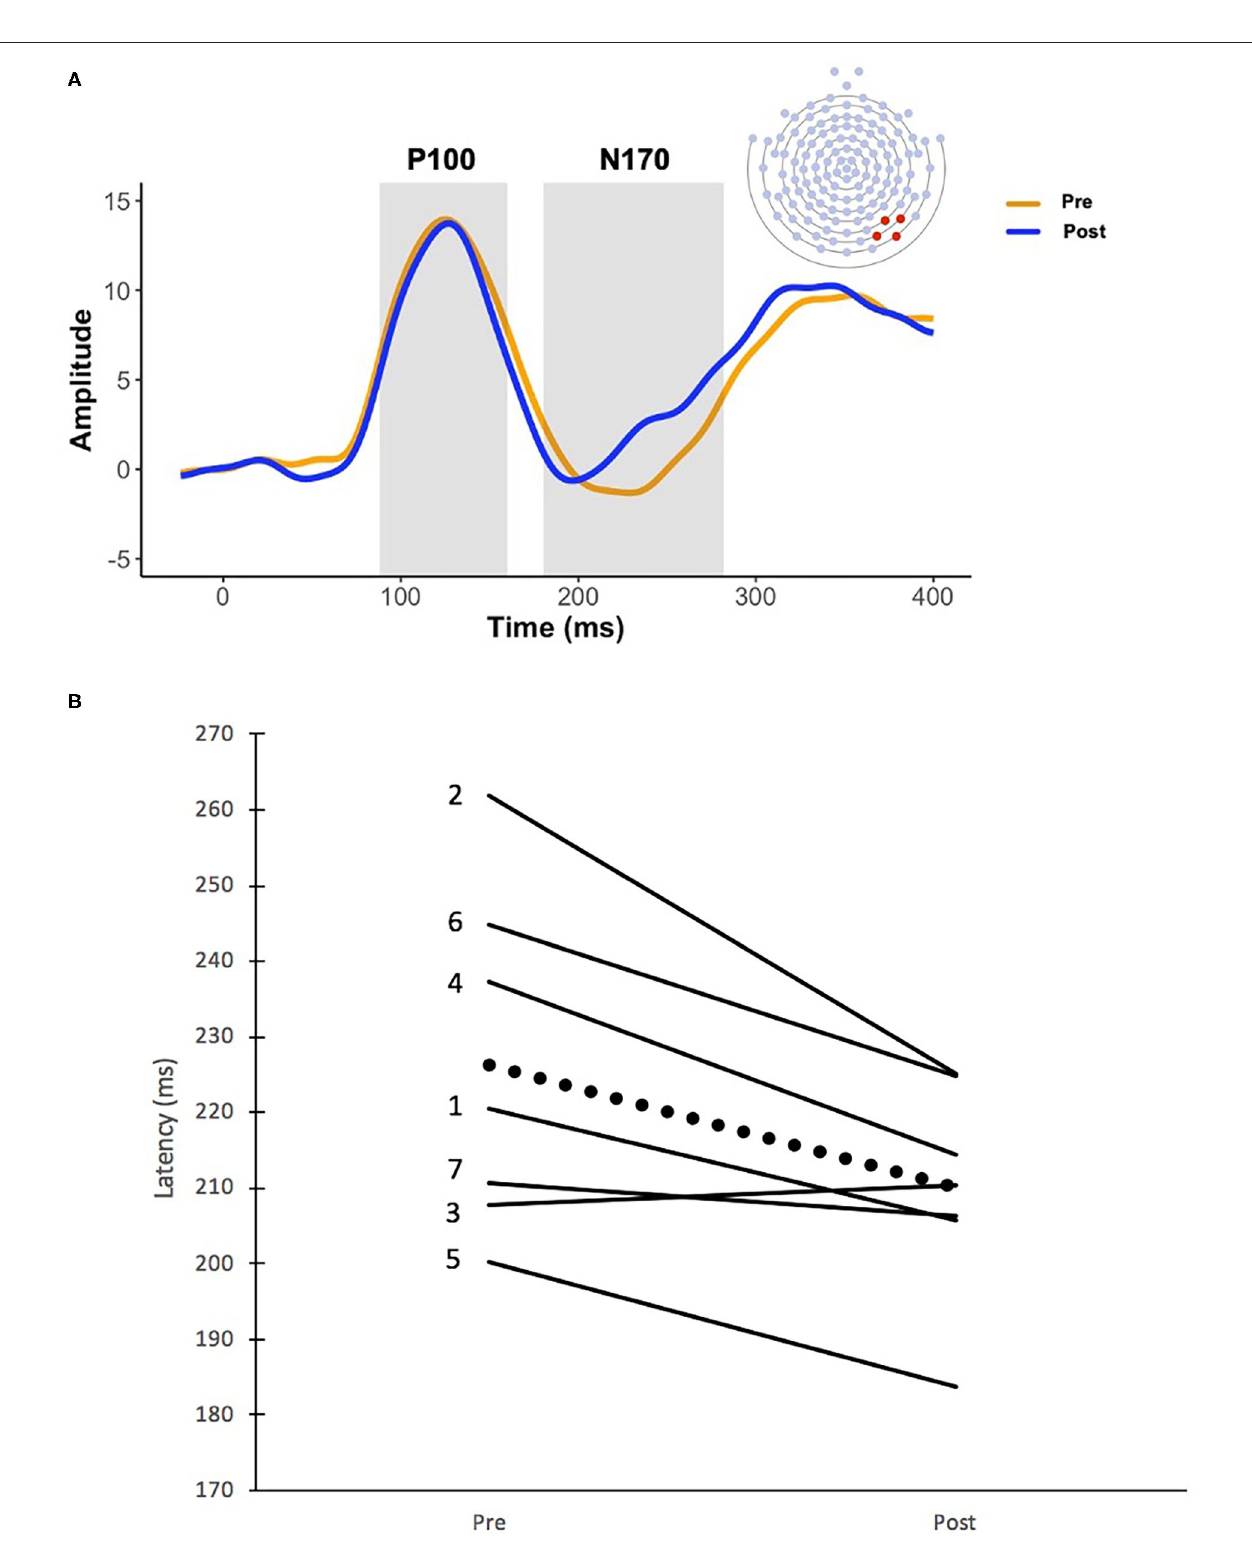
FIGURE 2 | (A) Grand averaged waveforms before and after 16 weeks of PRT. The orange line represents the recording prior to PRT and the blue line represents the recording after PRT. Temporal windows for the P100 (88–160ms) and the N170 (180–282ms) are represented by the gray boxes, and the P100 and N170 components are labeled accordingly. N170 electrode recording sites are also depicted. ERP data were averaged over the right occipitotemporal region (electrodes 89, 90, 94, 95). (B) Changes in N170 latency before and after 16 weeks of PRT. Solid lines indicate individual change in N170 latency for each of the seven subjects and the dotted line represents average group change. Numbers to the left of each line correspond with participant numbers listed in Table 1 .